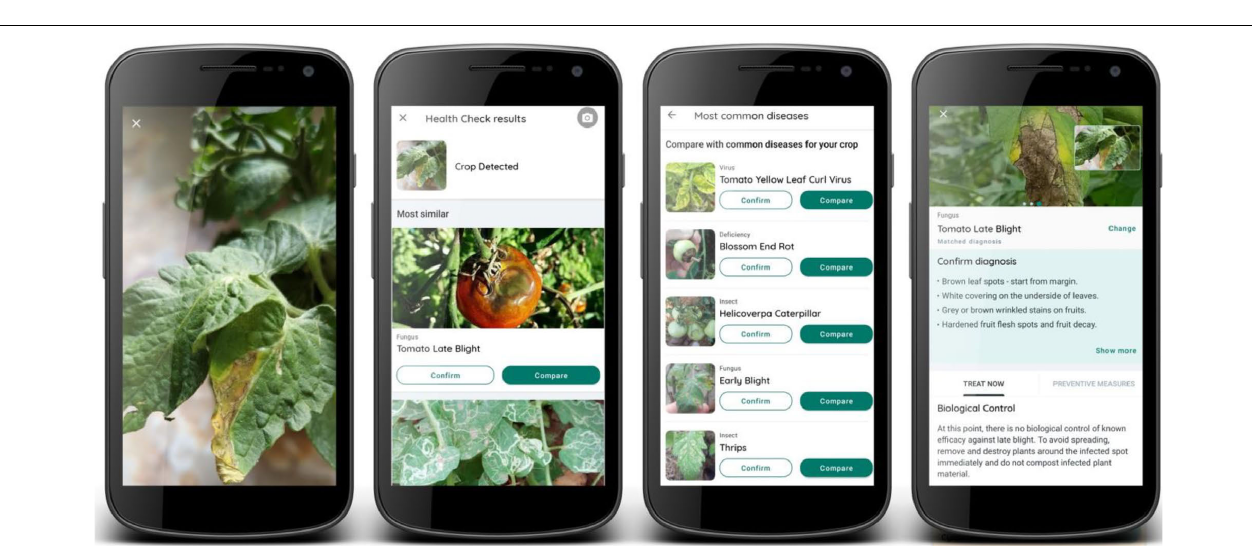
Frontiers in Plant Science |